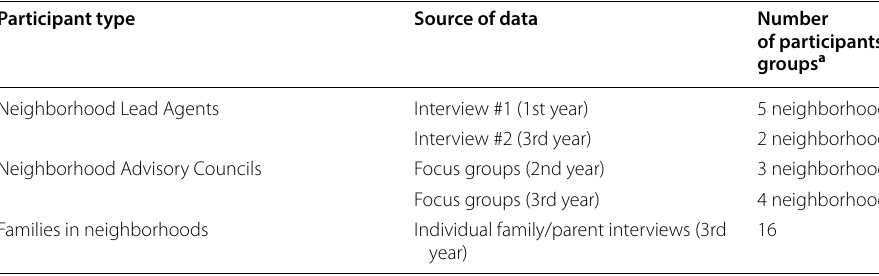
Table 2 Additional sources of